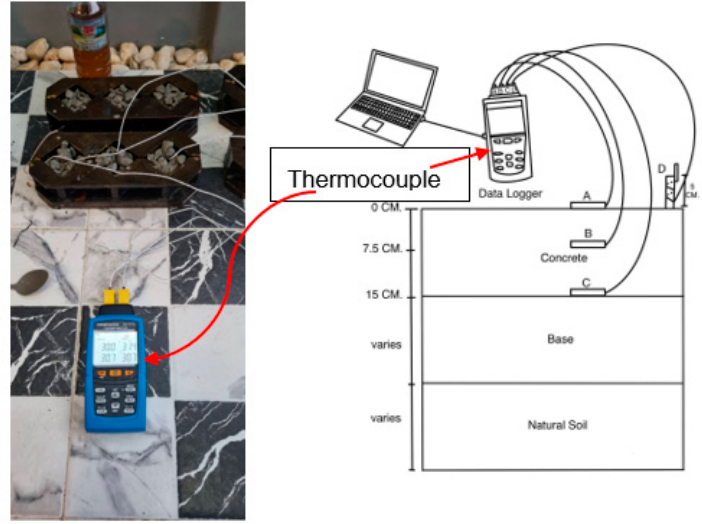
Figure 4. Temperature measurement scheme.